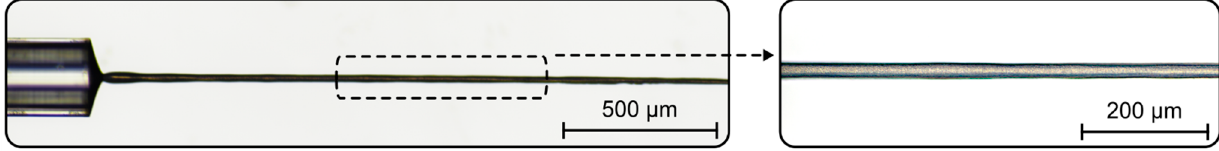
Figure 6. Microscopic images of a sapphire fiber with a reduced diameter of 25 μ m.